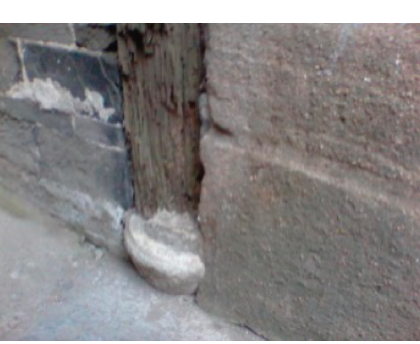
Figure 2: Unilateral column foot damage.